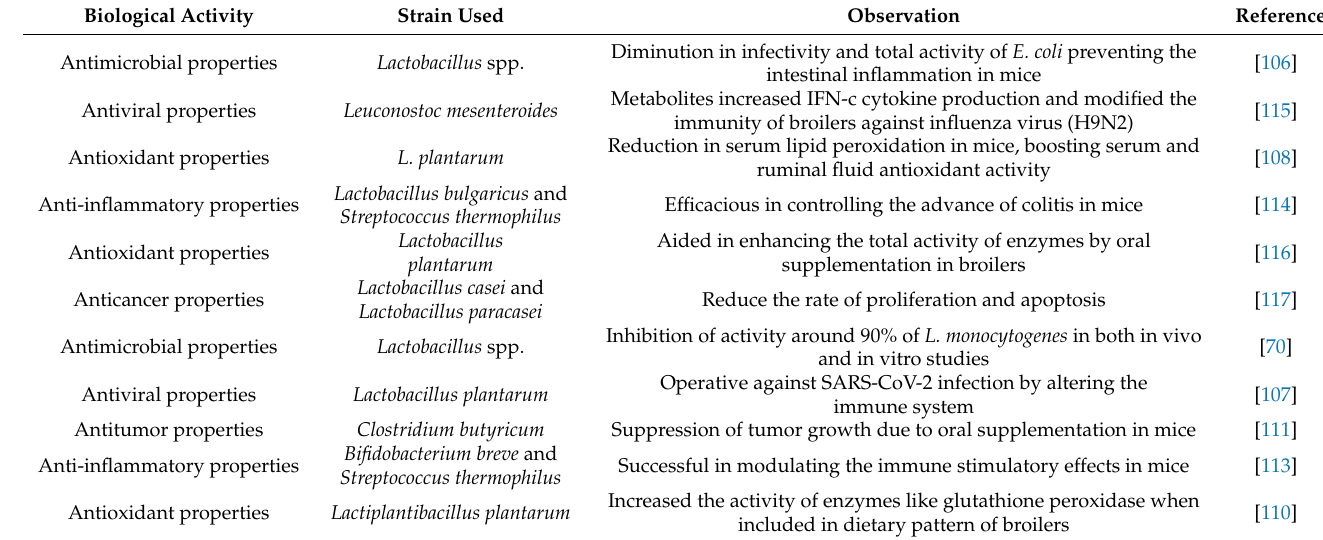
Table 1. Beneficial effects of postbiotics observed in in vivo